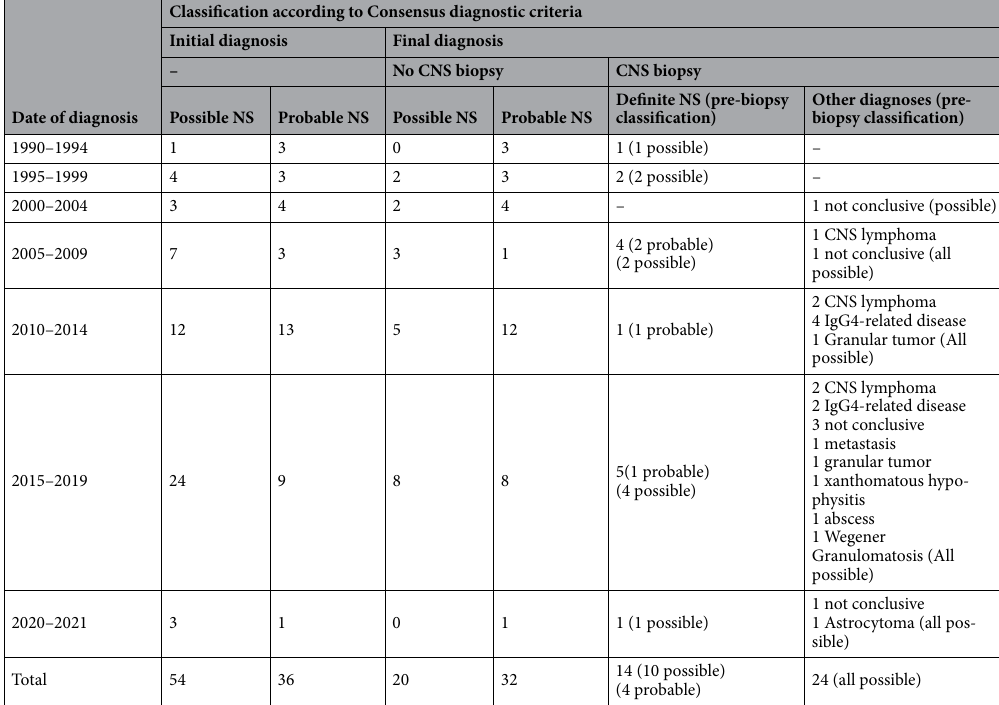
Table 4. Diagnostic classification of neurosarcoidosis according to date of diagnosis and CNS